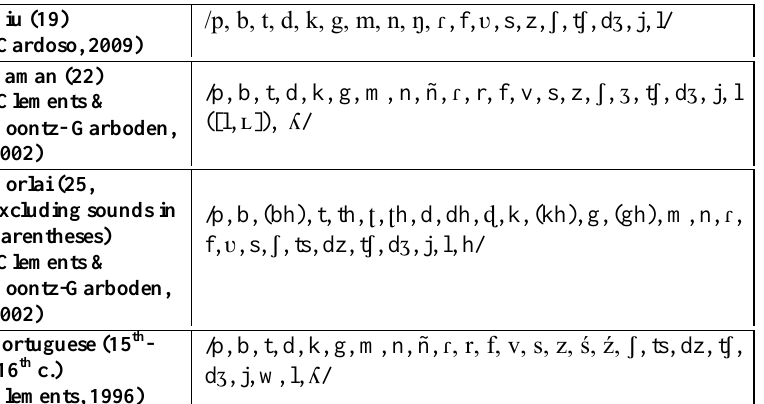
Table XII. Consonantal Phonemes